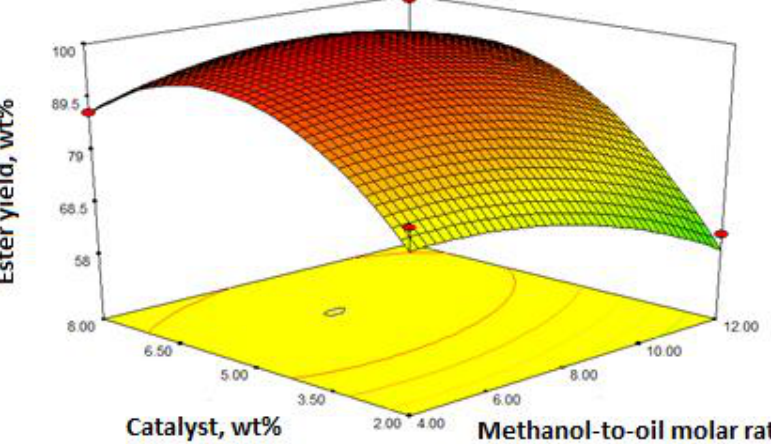
Figure 1. Experimental and predicted values of ester yield (wt%).